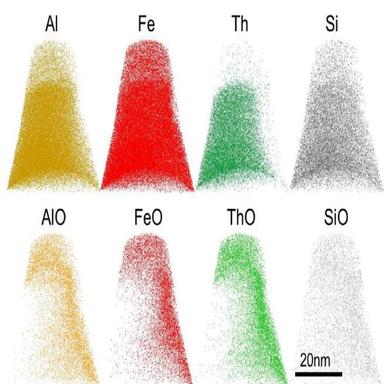
Reconstructions using ionic species of APT data from the AlFeTh particle in